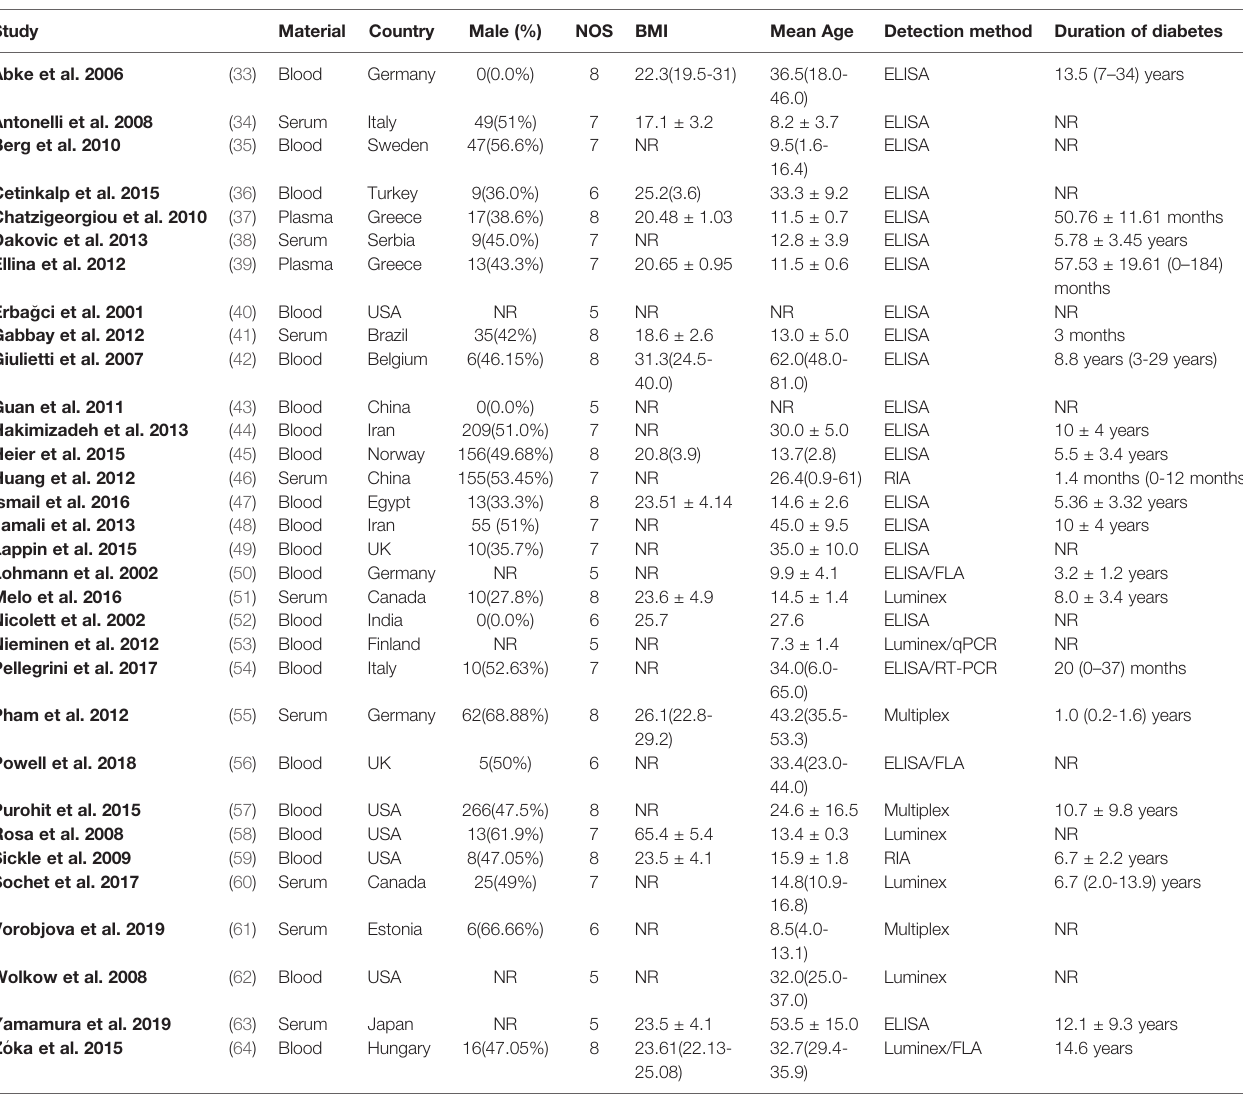
TABLE 1 | Characteristics of included